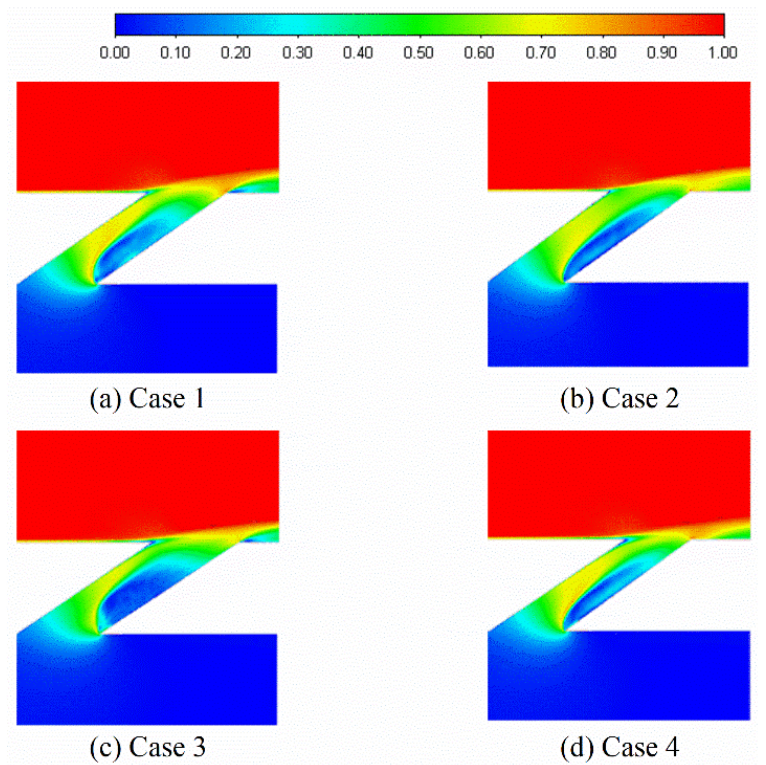
Figure 9. Time-averaged non-dimensional velocity distributions calculated from LES for different cooling holes in the center of the section plane.